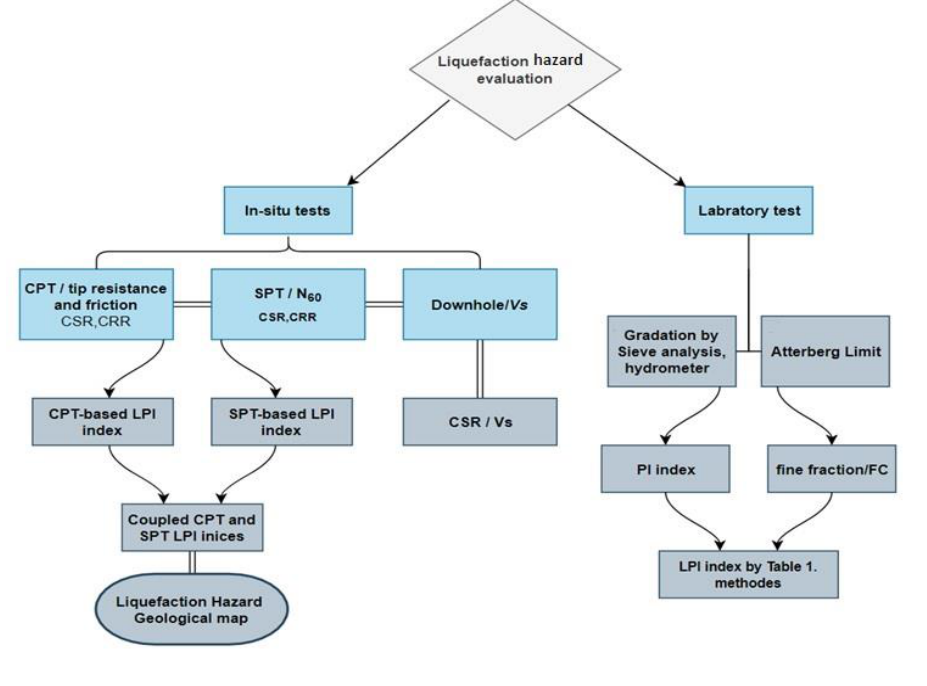
Figure 9: Flowchart of liquefaction hazard map